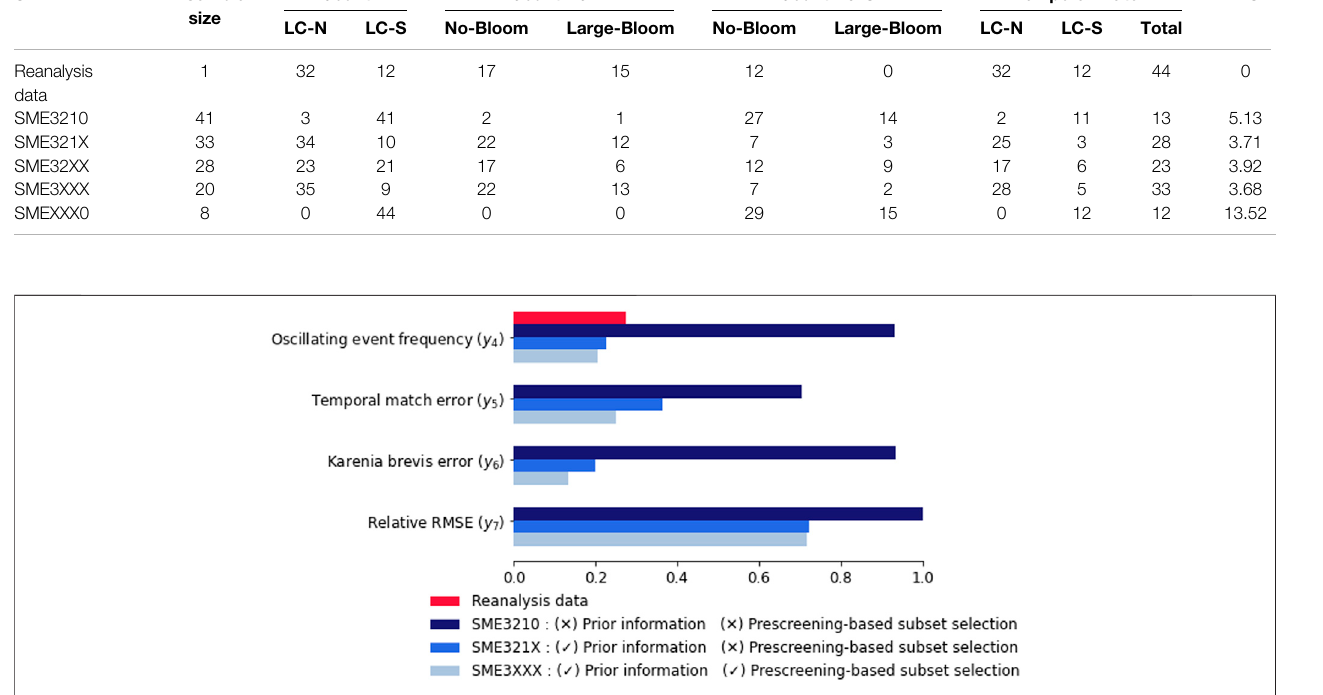
TABLE 3| RawdataofLoop CurrentatNorth (LC-N) and South (LC-S) positions,andtheir relation totheoccurrence oflargeblooms simple-average multi-model ensemble (SME). The ensemble size refers to the number of model runs per multi-model ensemble. SME Ensemble size